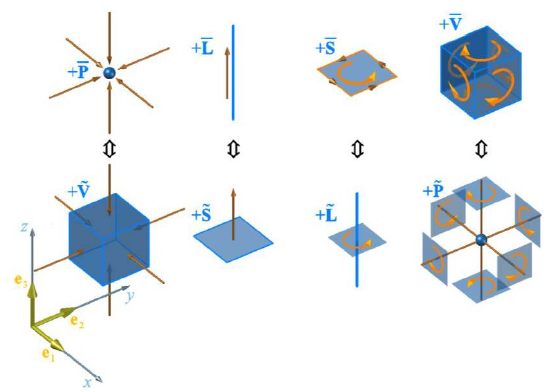
Figure 24: Relationship between the inner orientation of a p -space element and its dual element, of dimension p − 1 .